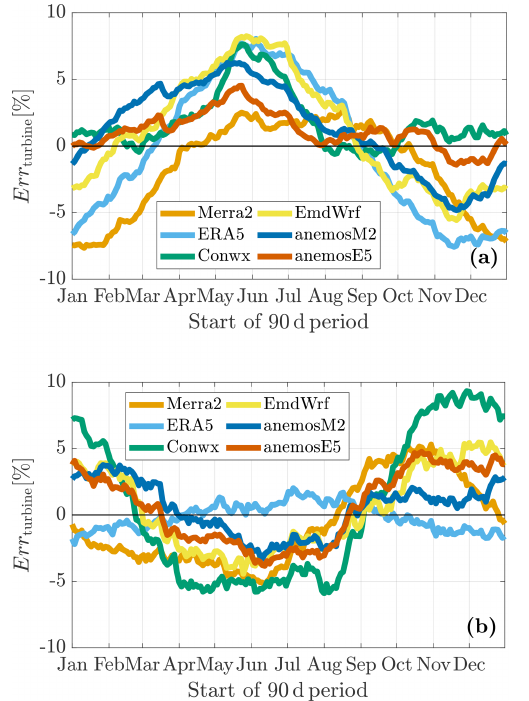
Figure 9. Temporal variations during the year of the bias in the theoretical annual energy production of a wind turbine Err turbine using the (a) variance ratio and (b) linear regression with residuals